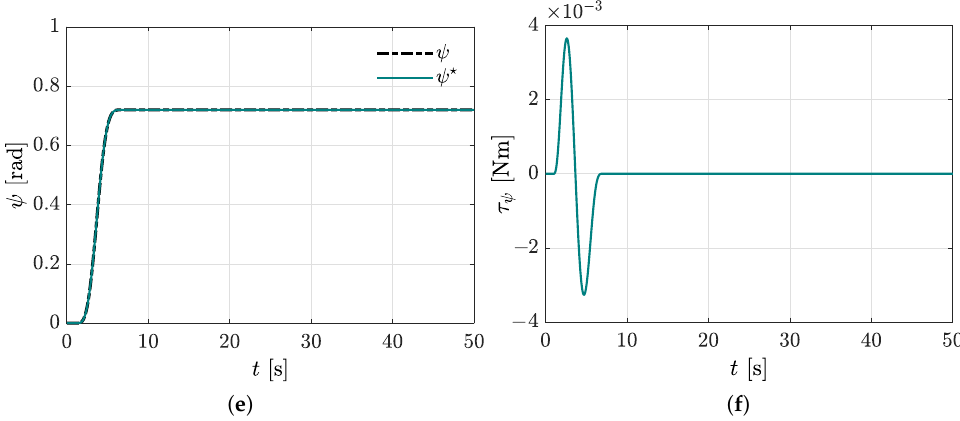
Figure 8. Unperturbed angular dynamics, case 2.1. ( a ) Tracking of the desired φ angle. ( b ) Computed control input τ φ . ( c ) Tracking of the desired θ angle. ( d ) Computed control input τ θ . ( e ) Tracking of the desired ψ angle. ( f ) Computed control input τ ψ .